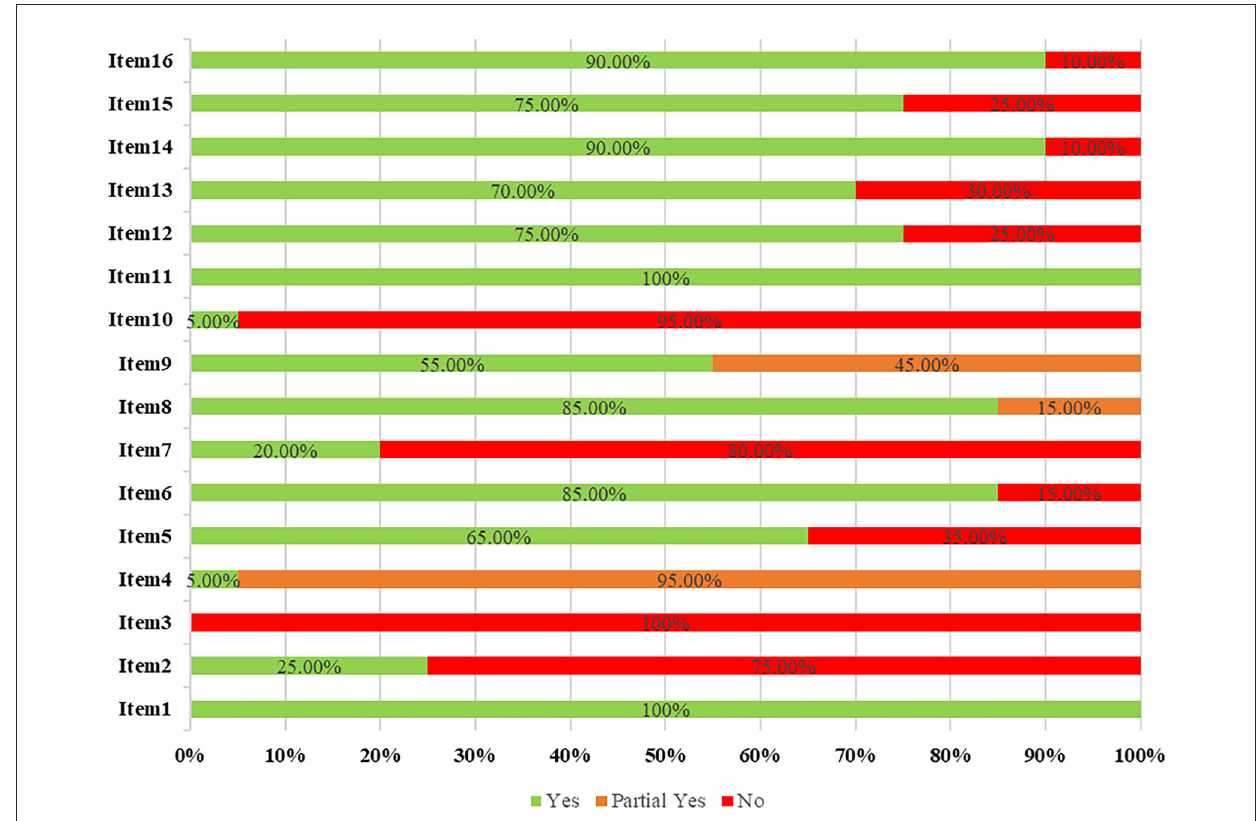
FIGURE3 Methodological quality of included meta-analyses based on the AMSTAR-2